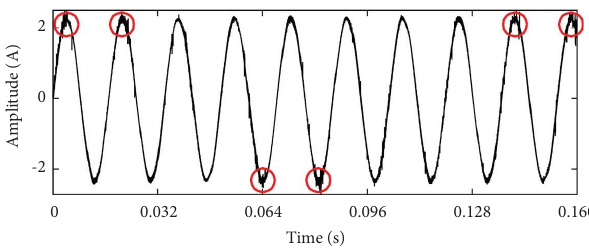
Figure 1: Te current with fault information